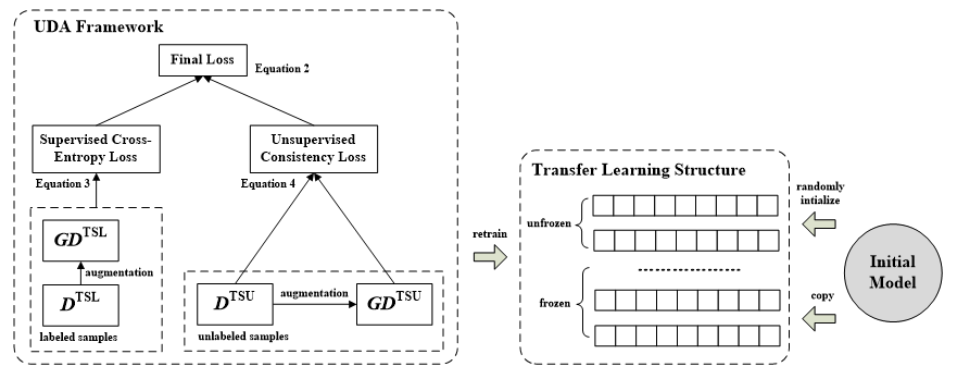
Figure 3. The proposed transfer semi-supervised learning